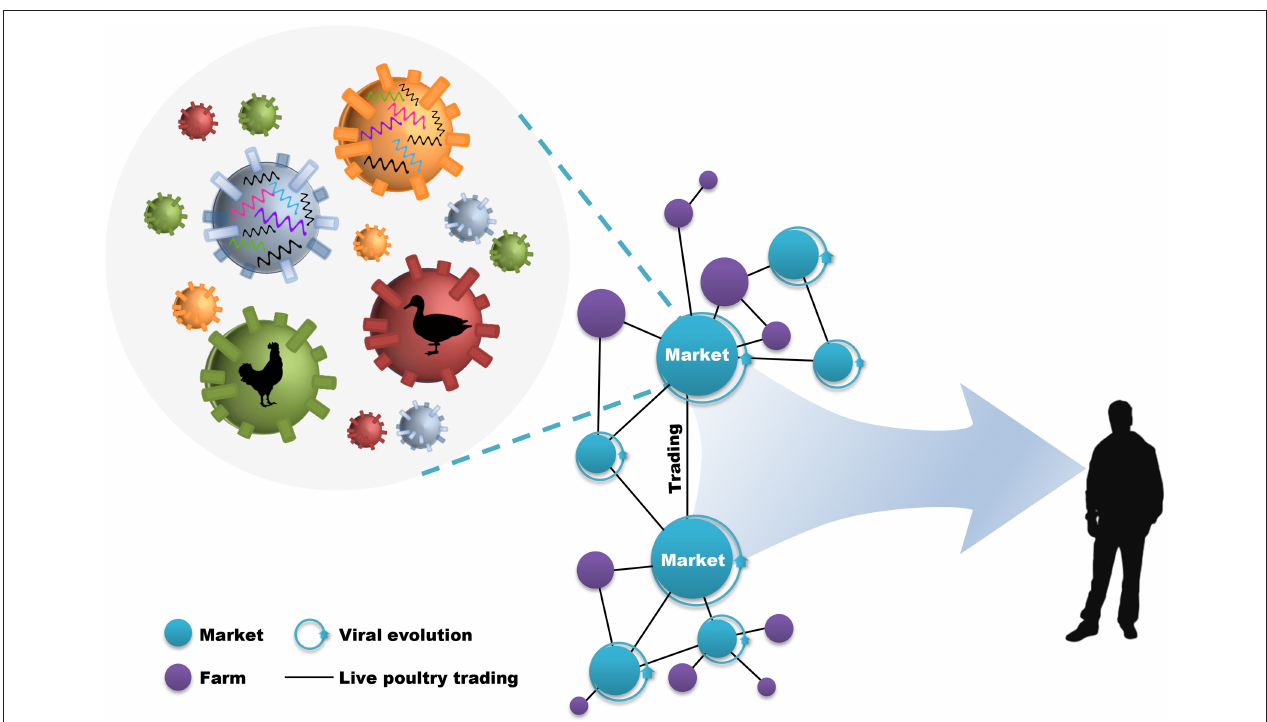
FIGURE 1 | Live poultry trading network drives viral evolution and poultry–humans sequential transmissions. The live poultry trading network consist of live poultry markets, farms, and the trading among them. The genetic evolution of avian influenza viruses is facilitated by the co-circulation of different viral subtypes and hosts within markets, and further expanded by poultry trading. This poultry trading framework increases the potential for poultry–humans sequential